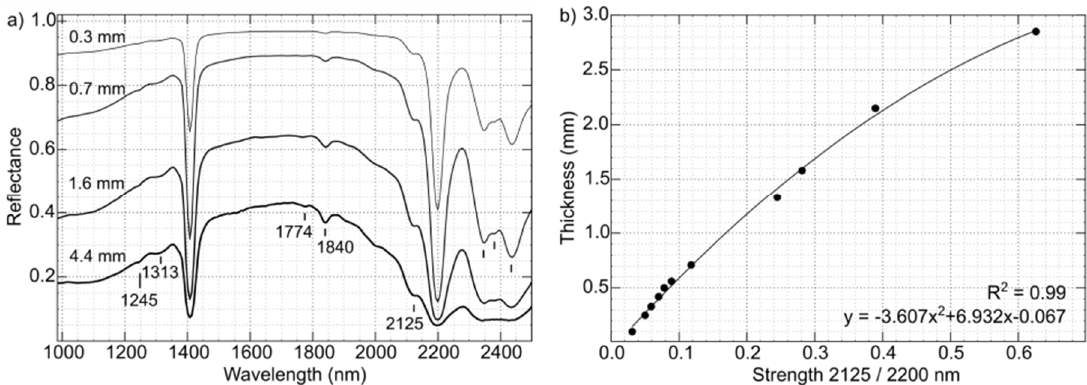
Figure 3. Variation of the spectral response of white mica as a function of thickness. ( a ) Spectra of white mica sheets of variable thickness measured with precision calipers. Reflectance spectra are shown without any offset and are not continuum removed. Spectra are available in Table S1. ( b ) Correlation between the relative second derivative strengths of the 2125 nm and 2200 nm absorptions and sample thickness.